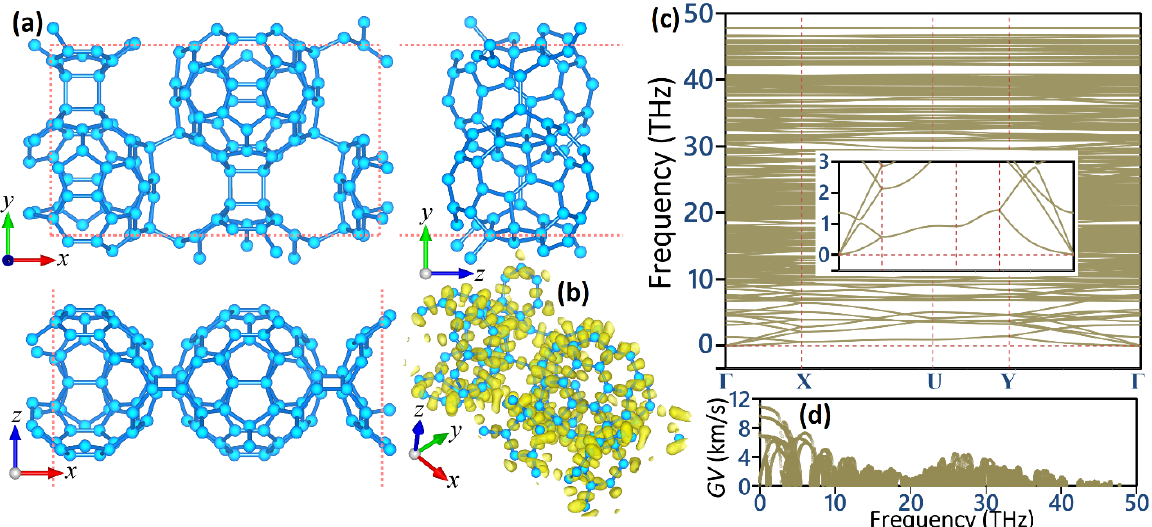
Figure 1. ( a ) Top and side views of the qHPC 60 monolayer. ( b ) Electron localization function (ELF) with an isosurface value of 0.8, plotted using the VESTA package [33]. MTP-based predicted ( c ) phonon dispersion relation and ( d ) phonon group velocity ( GV ) of the qHPC 60 monolayer.